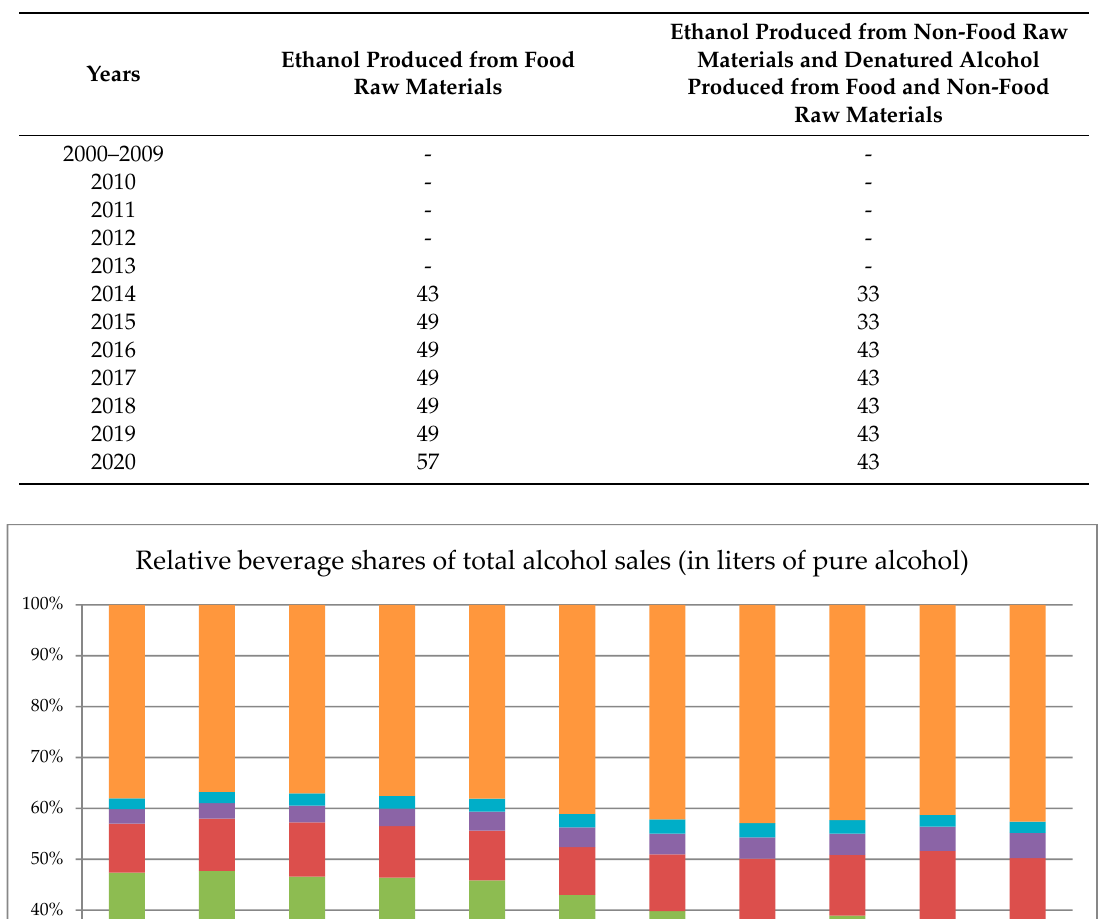
Table A5. Minimum prices for ethyl alcohol in rubles per 1 L. Source: Federal Service for Alcohol Market Regulation.